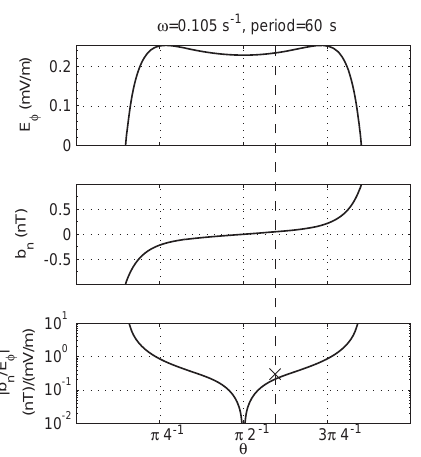
Figure 12. The solutions of E φ (in mV/m), b n (in nT) and the ratio inbetween (from top to bottom panels) for the standard dipole of the same set of parameters as Dai et al. (2013). Format is the same as Fig. 11.